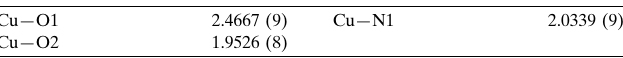
Selected bond lengths (A˚